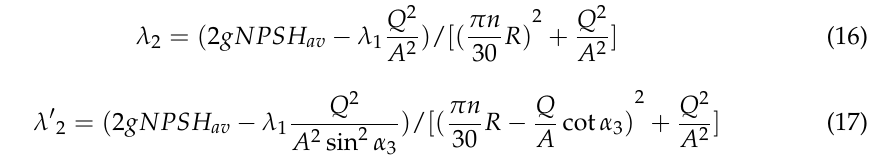
λ′ and with minimum NPSH c for 5 blade angles. 2 2